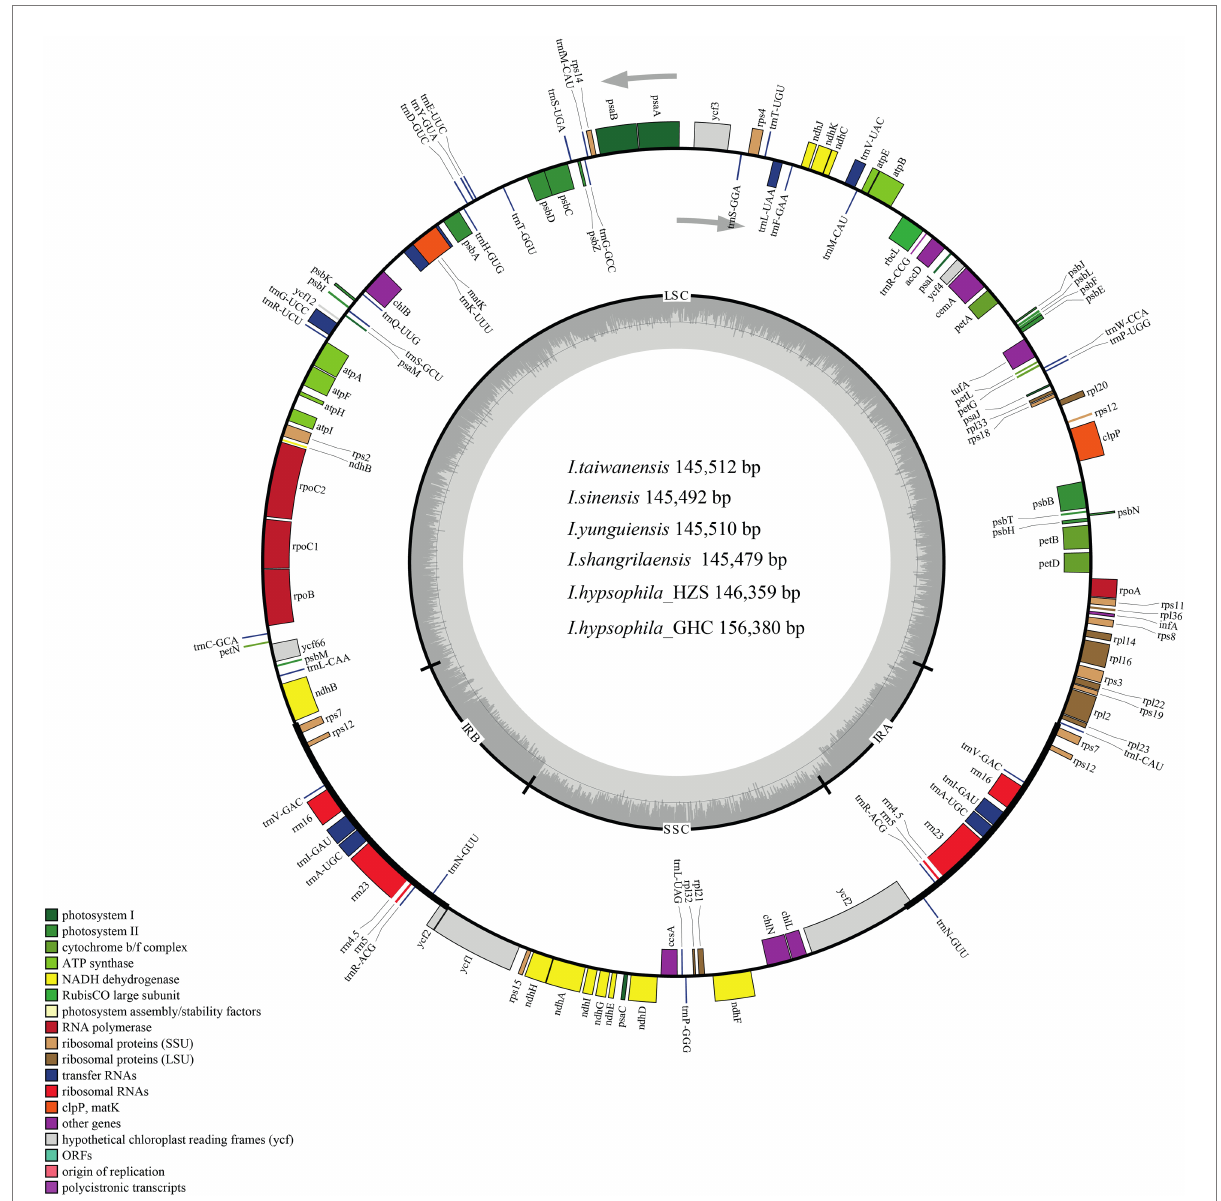
FIGURE 1 Chloroplast genome maps of Isoetes species. Genes belonging to different functional groups are color-coded. The darker grey in the inner circle shows the GC content, while the lighter grey shows the AT